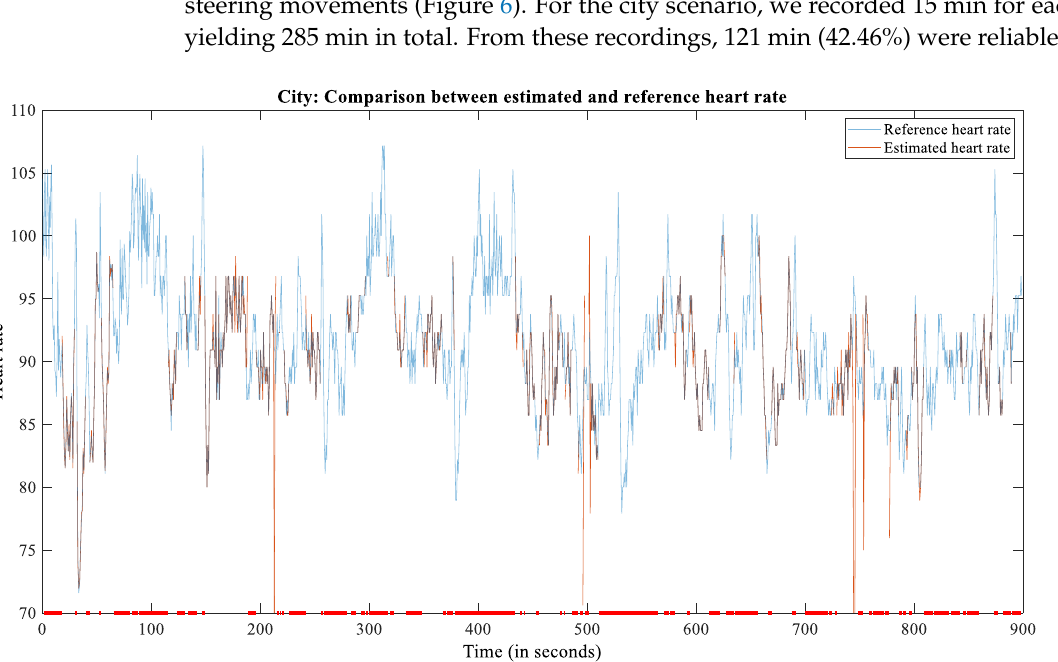
Figure 7 . The plot of reference and estimated HR for subject 2209 during the highway scenario. On rural roads, the SNR was lowest (Figure 8). In total, 136 min out of 285 min (47.72%) were labeled as usable.